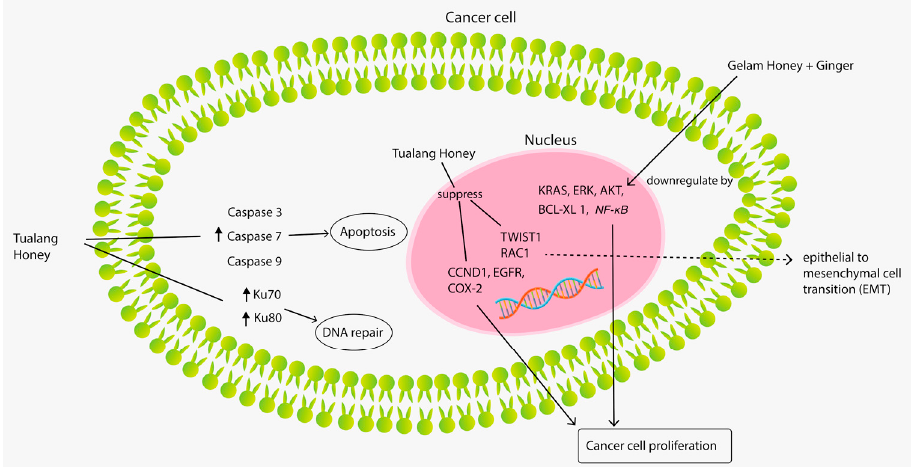
Figure 3. Anti-cancer mechanism of Tualang, Gelam and Kelulut honeys. KRAS: K-Ras encoding gene; ERK: extracellular signal-regulated kinase; AKT: protein kinase B; Bcl-xL: B-cell lymphoma-extra-large; NF-kB: nuclear factor kappa B; TWIST1: Twist-related protein 1 gene; RAC1: Ras-related C3 botulinum toxin substrate 1 gene; CCND1: Cyclin D1 gene; EGFR: epidermal growth factor receptor gene; COX-2: cyclooxygenase-2.